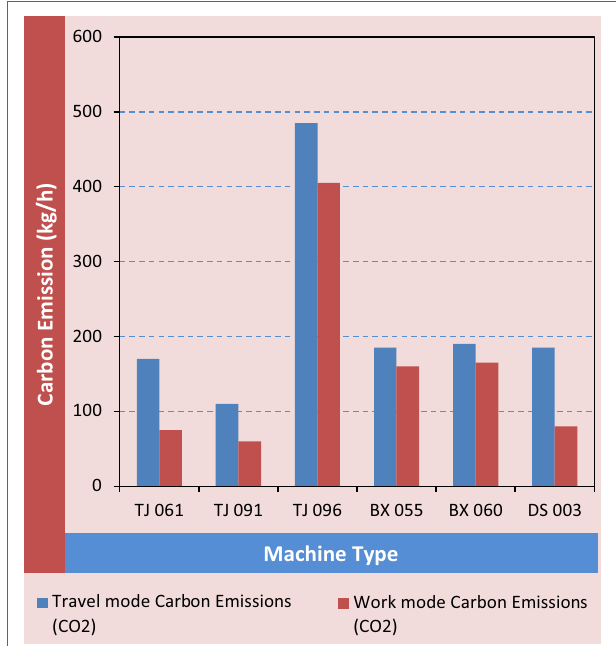
Figure 6 | Comparison of carbon emissions from rail resurfacing machineries (Krezo et al.,